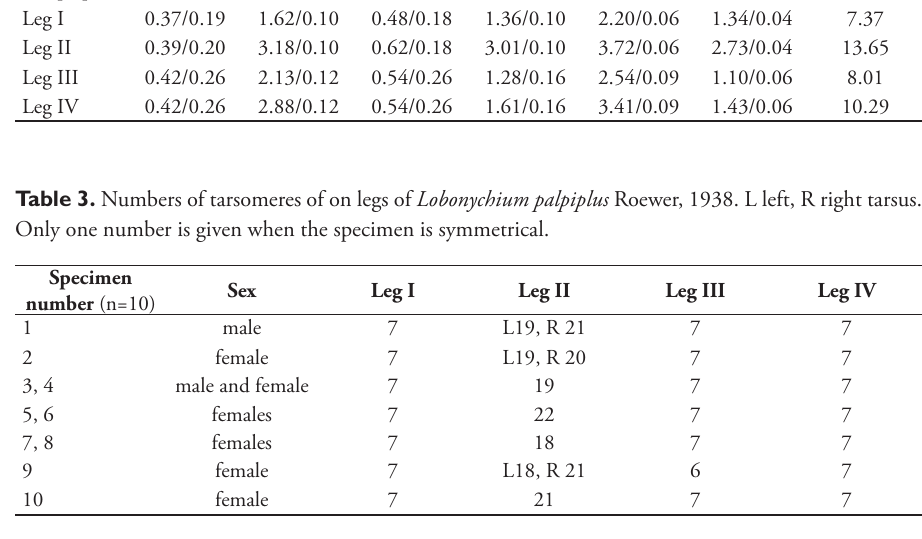
of capsula externa (follis) (Fig. 30), stylus with capsula interna sunken into capsula ex- terna (Fig. 27). Capsula externa dorsally and ventrally extended at distal end. Everted capsula interna with a bifurcate ventral lobe distally. Stylus finger-shaped. Spination